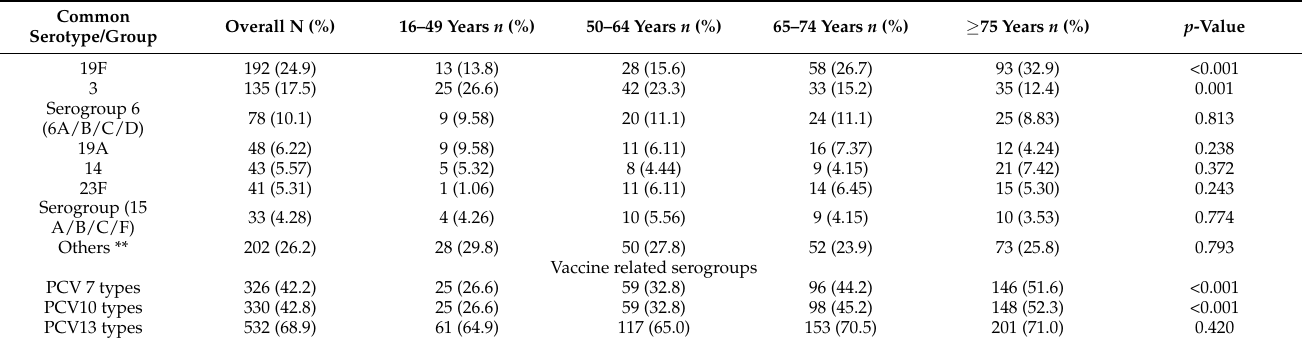
Table 2. Distribution of common serotypes/groups isolated from patients ( p -values by Fisher’s exact test or Chi-square test). Common Serotype/Group